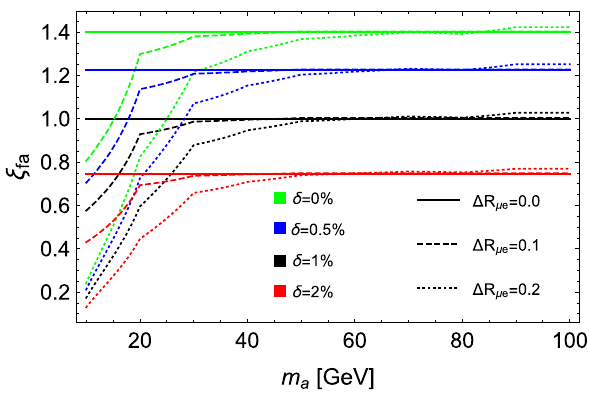
≡ f δ,Δ R e μ / f 1% , 0 Fig. 3 Relative change ξ f a a in the projected bounds a on f a with 300 fb − 1 of data. We plot the relative change against the baseline presented in Fig. 2 for different values of systematic uncertain- ties δ = 0 , 0 . 5 , 1 , and 2% (green, blue, black, and red) and choosing three different separation cuts Δ R e μ > 0 (solid) 0 . 1 (dashed) and 0 . 2 (dotted) respectively